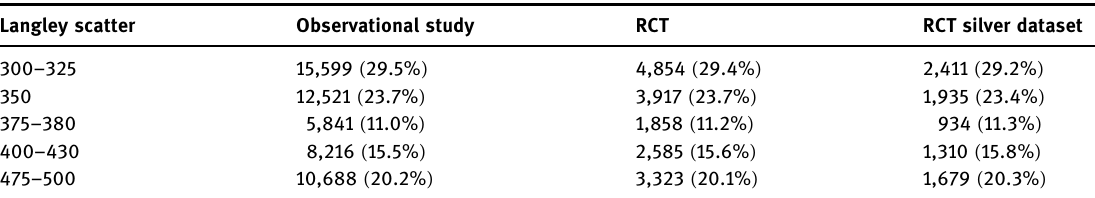
Table A9: Distribution of langley scatter ( g - cal/ cm 2 ) variable across categories in the observational study, RCT, and RCT silver datasets Langley